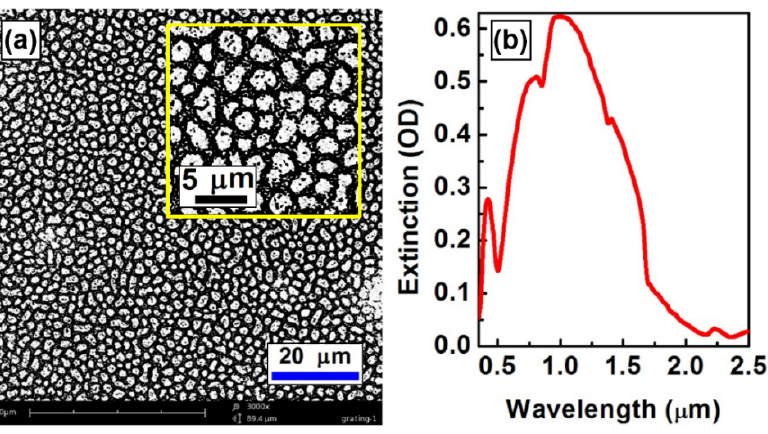
Figure 6. ( a ) SEM image of the metalized phase-separation scheme of the F8BT:PFB blend film; ( b ) Optical extinction spectrum measured on the structures shown in ( a ).